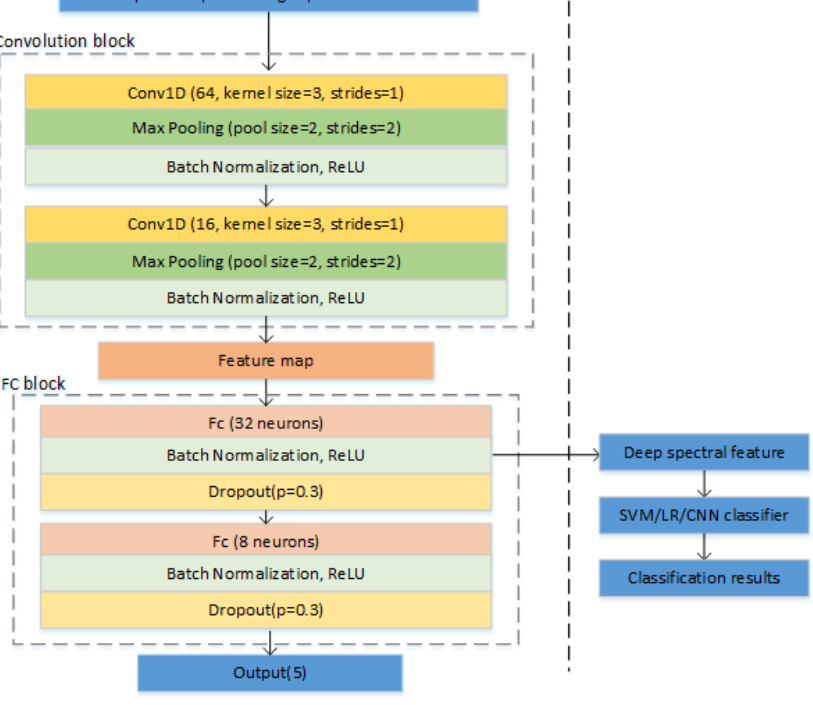
Figure 2. The structure of the convolutional neural network (CNN) and the flowchart of deep spectral features used in the support vector machine (SVM)/logistic regression (LR)/CNN classifier.